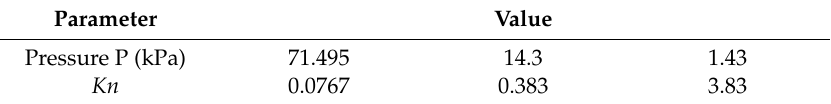
Table 1. Knudsen numbers for di ff erent pressures, VHS